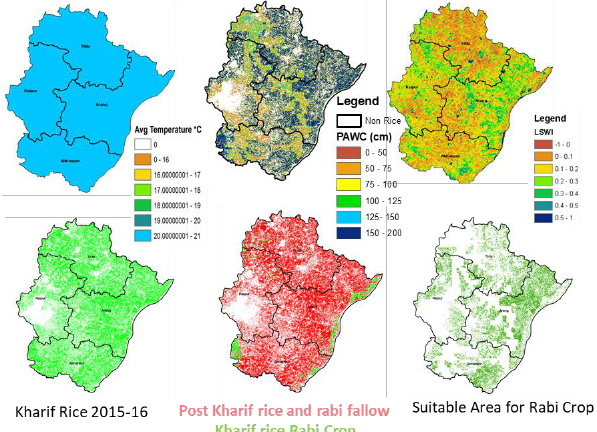
Figure 3: Block wise maps of Average temperature, PAWC, LSWI, Kharif rice, post kharif rice and rabi fallow and suitable area for Raipur district, Chhattisgarh